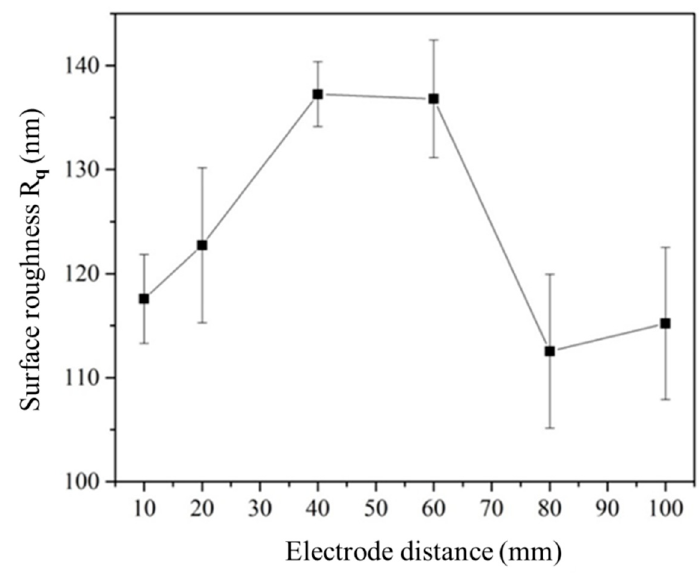
Figure 11. Surface roughness R q mean and standard deviation values for various electrode distances when the cathodic specimen speed of 0.125 mm/s and the applied voltage of 220 V are fixed.